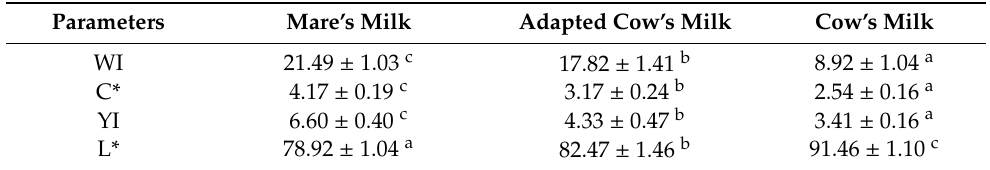
Table 2. Assessment of the color of mare’s milk, cow’s milk adapted to mare’s milk composition, and cow’s milk.